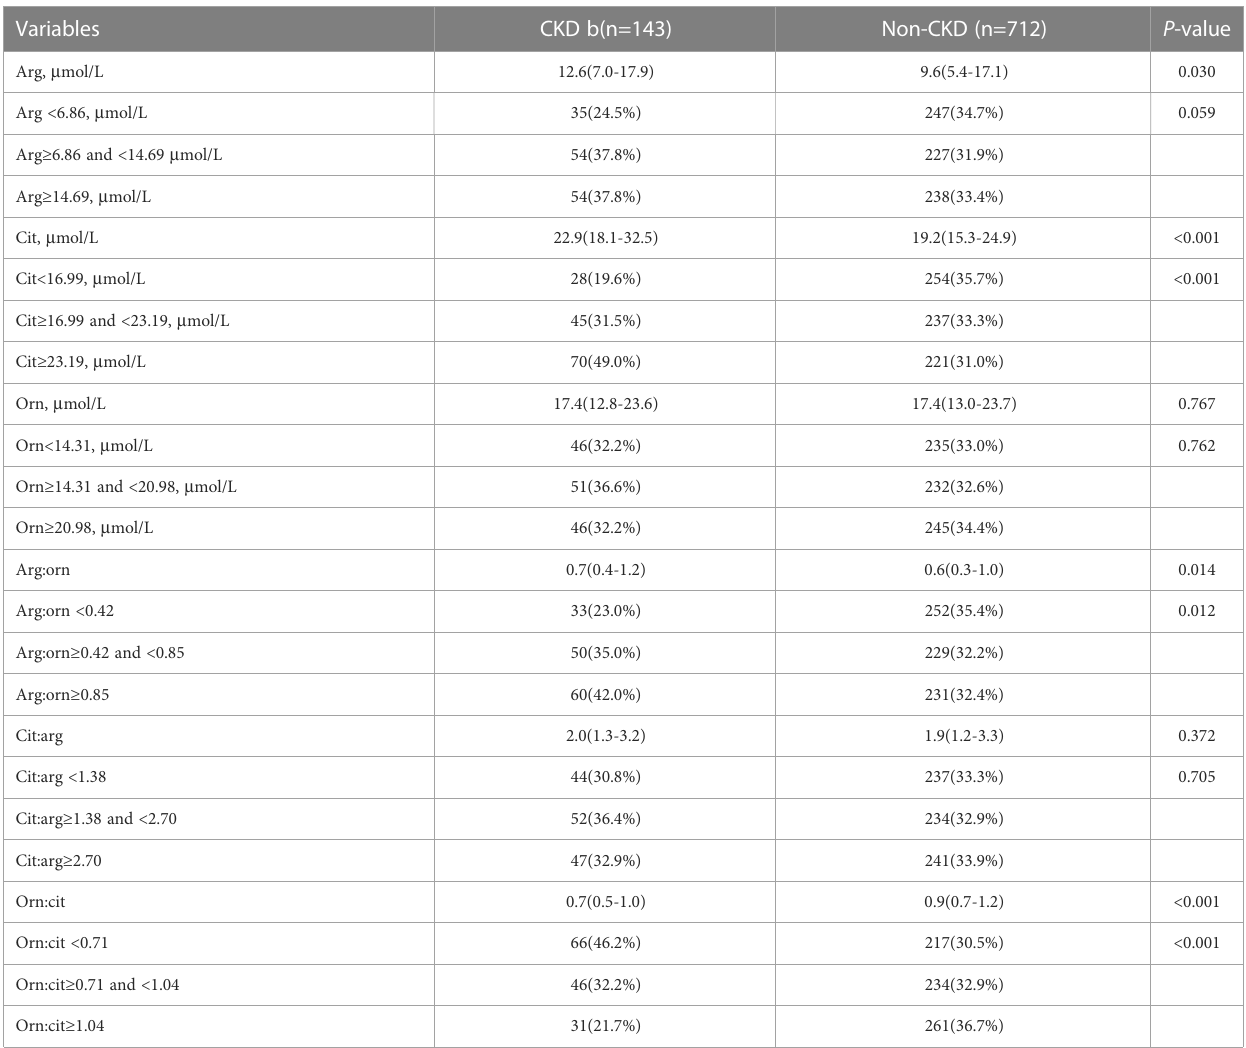
TABLE 2 Amino acids pro fi le by CKD